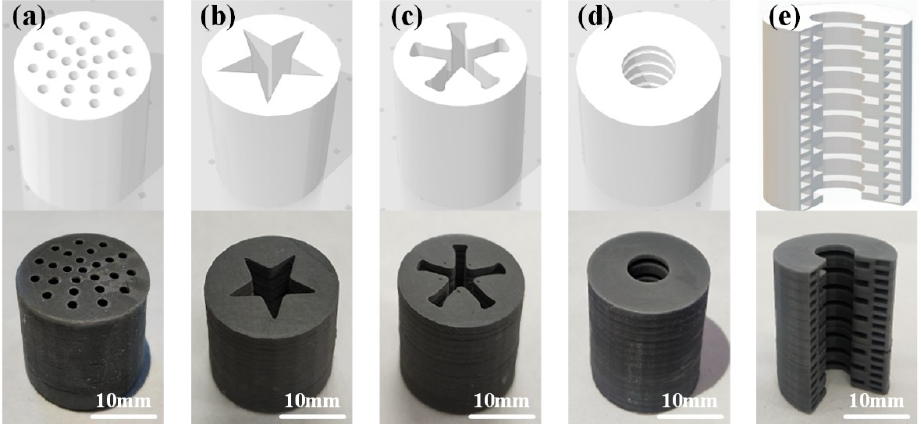
Figure 6. ( a ) The specific process of 3D printing. ( b ) Real samples of special-shaped energetic grains. The printed real samples of different special-shaped grains were compared with the three-dimensional CAD models of special-shaped grains, as shown in Figure 7 (the light color represents grain 3D models, while the dark color represents real grain samples).